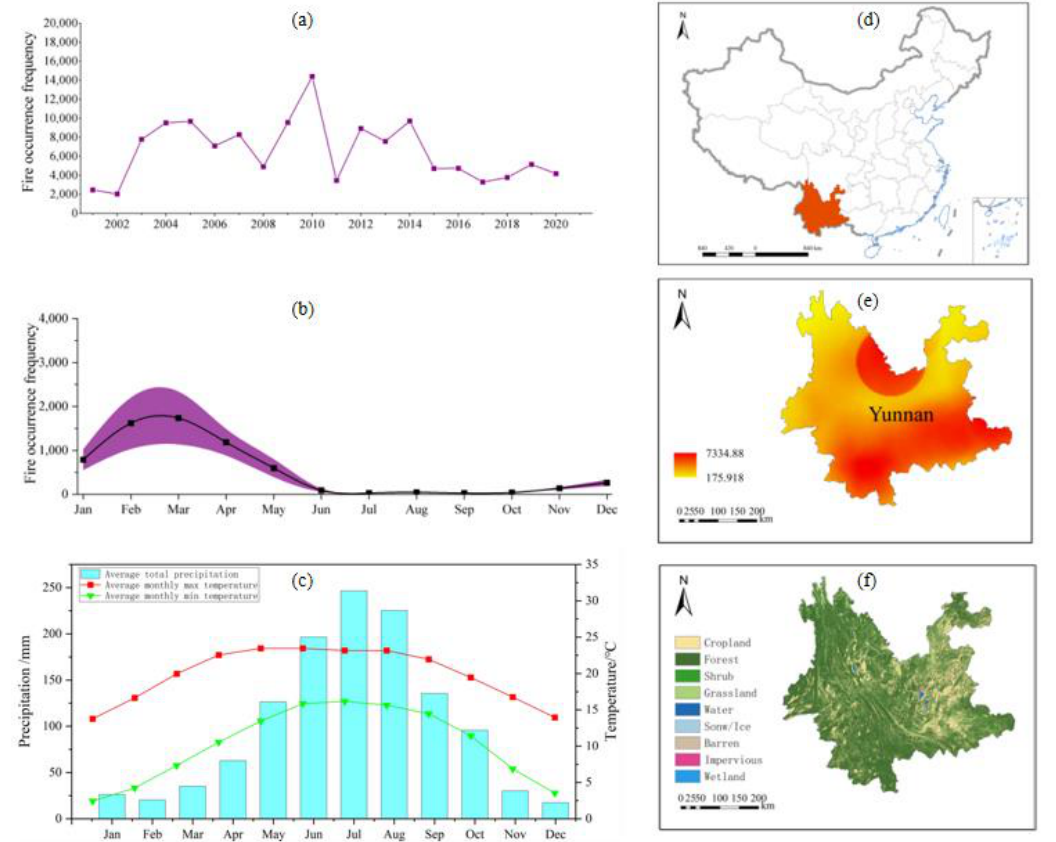
Figure 6. The total ( a ) occurrence frequencies of active fires over the study period, ( b ) monthly average number of active fire occurrence frequencies and their 95% confidence intervals (purple area), ( c ) average rainfall and temperature, ( d ) geographical position of Yunnan in China, ( e ) spatial dif- ference in hotspot density of active fires during 2001 – 2020, and ( f ) spatial difference in land cover in Yunnan in 2020.